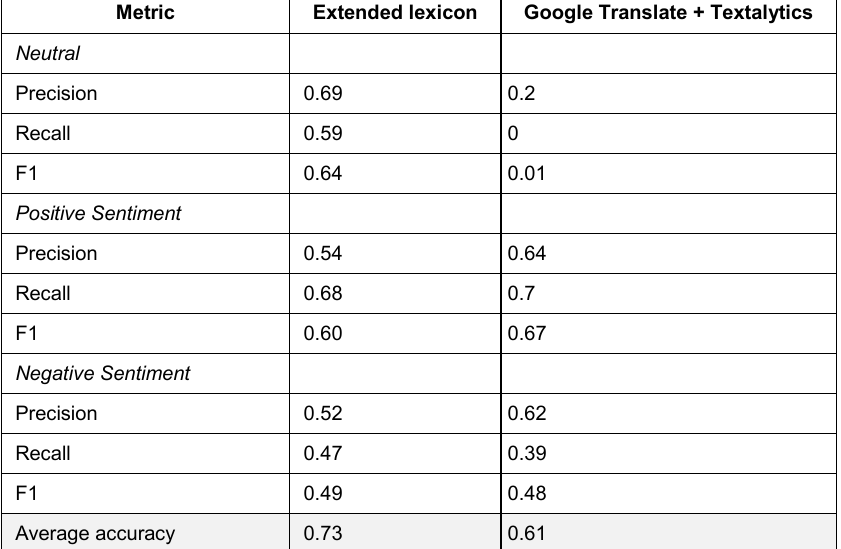
Table 3. Latvian extended lexicon compared